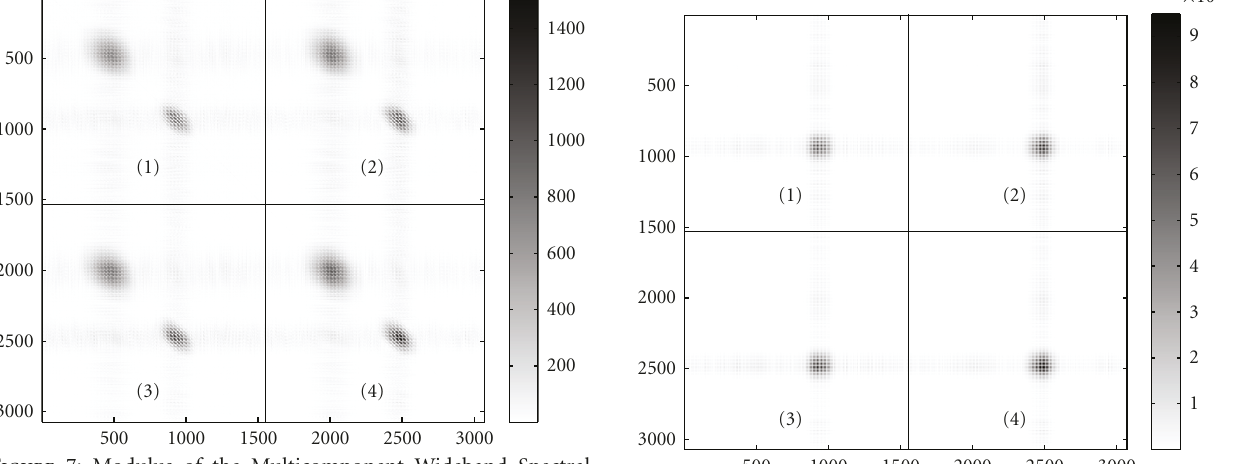
Figure 7: Modulus of the Multicomponent Wideband Spectral Matrix of the initial dataset (of size 3072 × 3072 with 3072 = 24 × 64 × 2). Compared with Figure 1, block 1 is Γ and blocks 2 and 3 are Γ Γ ZZ